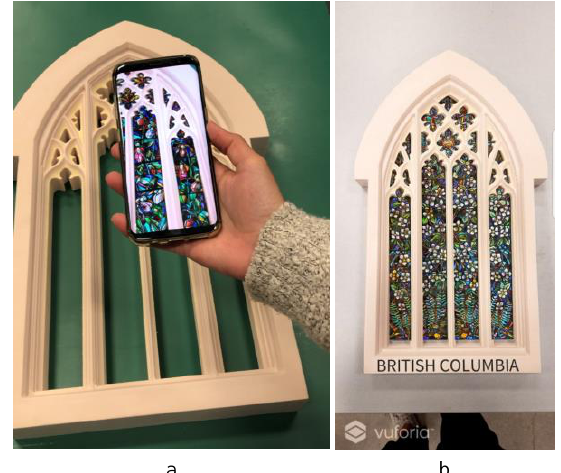
Figure 6: a) AR experience. b) Screenshot of the AR